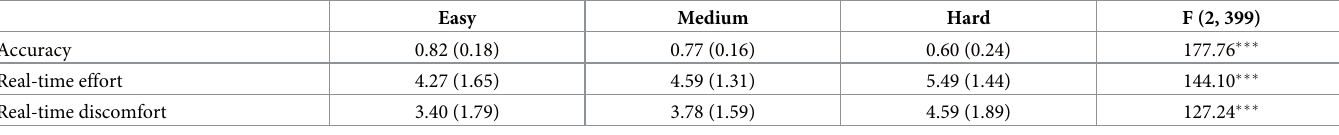
Table 2. Mean (SD) for accuracy, real-time ratings of effort and real-time ratings of discomfort across levels of task difficulty.